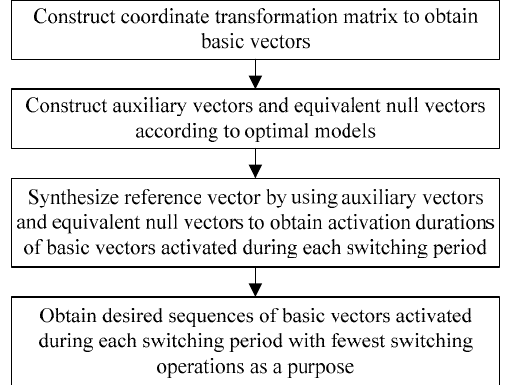
Figure 4. Research route of Fault-tolerant SVPWM.